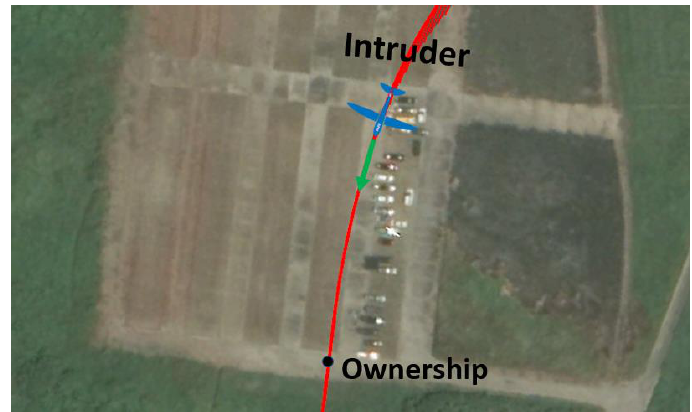
Figure 26. Flight path of the intruder in Experiment 3.